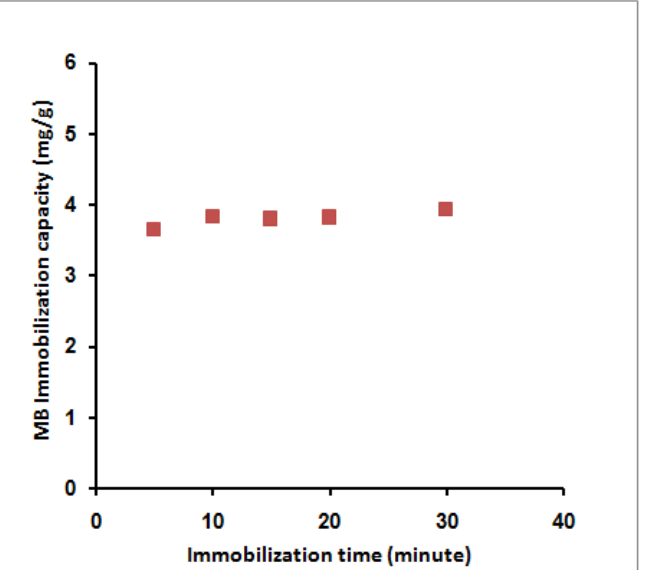
Figure 6. Effect of MB immobilization time on its immobilization capacity; 10 mL MB, 40 ppm, room temperature, 0.1 g SPGMA, rpm 200, and 6.5 pH.